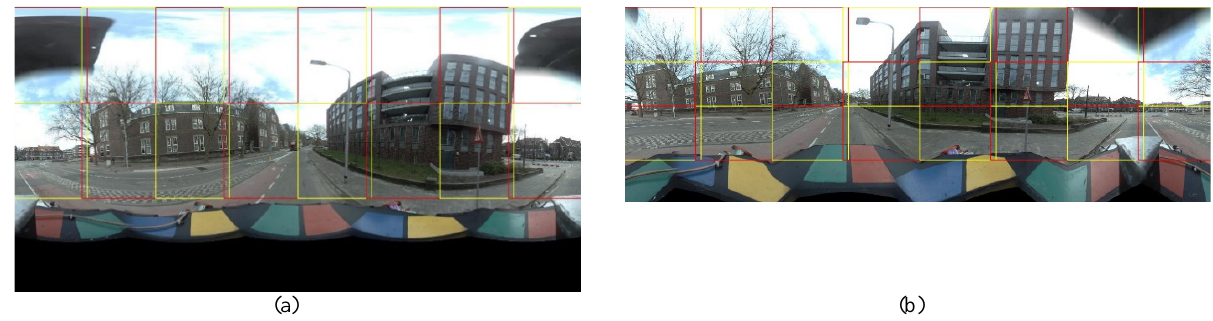
Figure 5. Image cropping. (a) Cropping arrangement of the original panoramic images. (b) The transformed images.